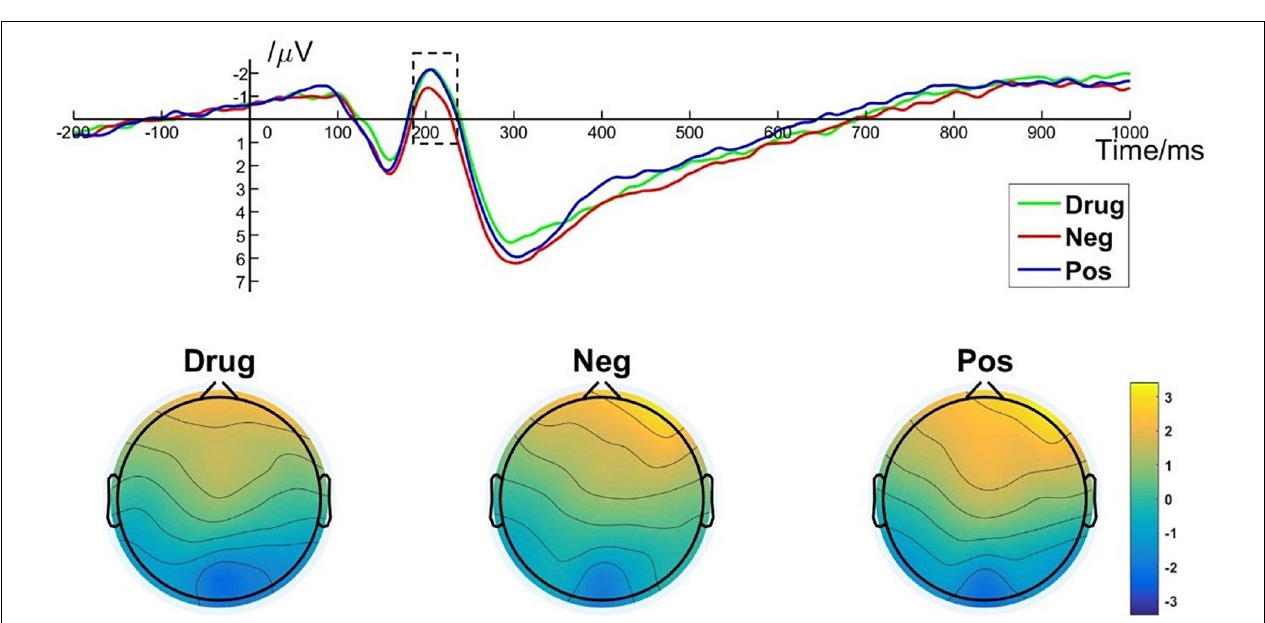
FIGURE 5 | EPN component elicited under different conditions at electrode sites PO7, PO8, and brain topography of